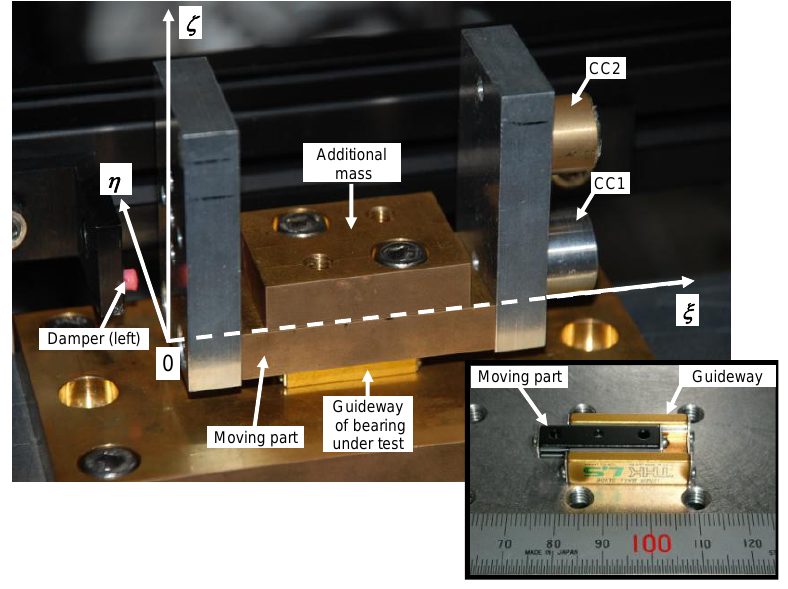
Figure 2. Photographs of the bearing under testing, in which the coordinate system is